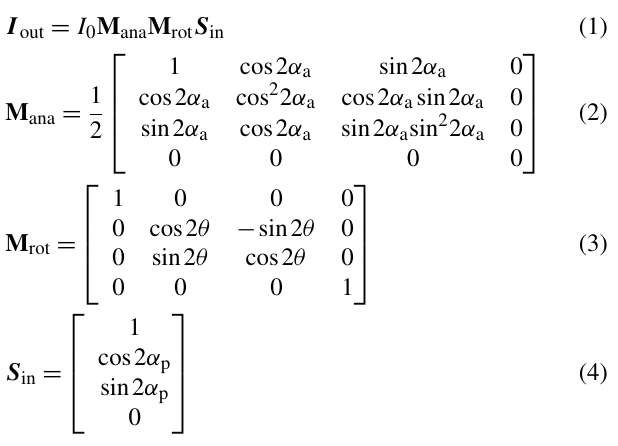
larization of light by a Poincare sphere. In this article, the Mueller matrix approach has been considered for the calcu- lation. As written in Eq. (1), the output intensity ( I out ) of a light beam can be expressed in terms of the Mueller matrix of a Faraday rotator ( M rot ), the Mueller matrix of an analyzer ( M ana ) and the Stokes vector ( S in ) of the linearly polarized input beam ( I 0